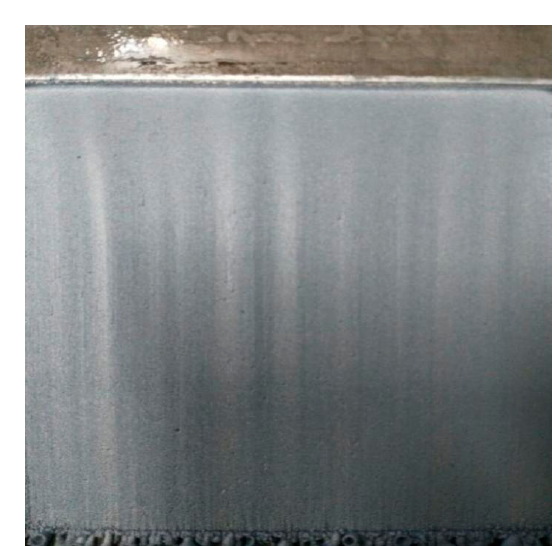
Figure 10. Electrowon zinc product.